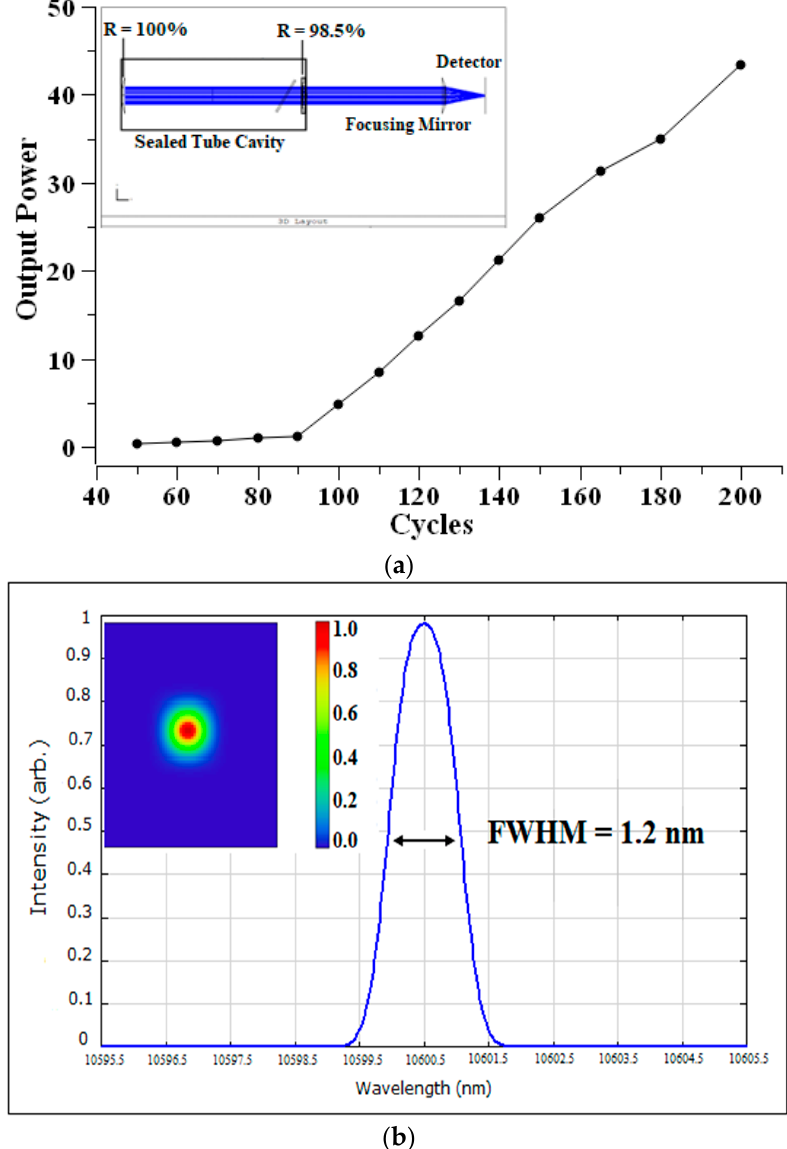
Figure 1. ( a ) Output power variation w.r.t number of cycles in the cavity (inset: 2D layout of the cavity). ( b ) Output beam spectrum of design laser cavity in Zemax Optic Studio (inset: beam spot).